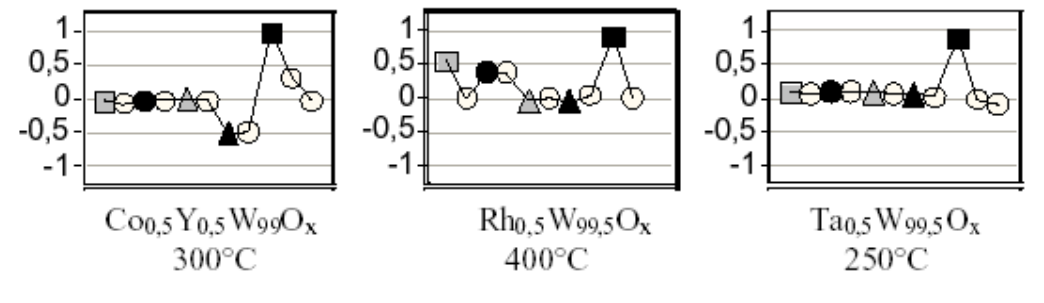
Figure 7. Fingerprints of selected single